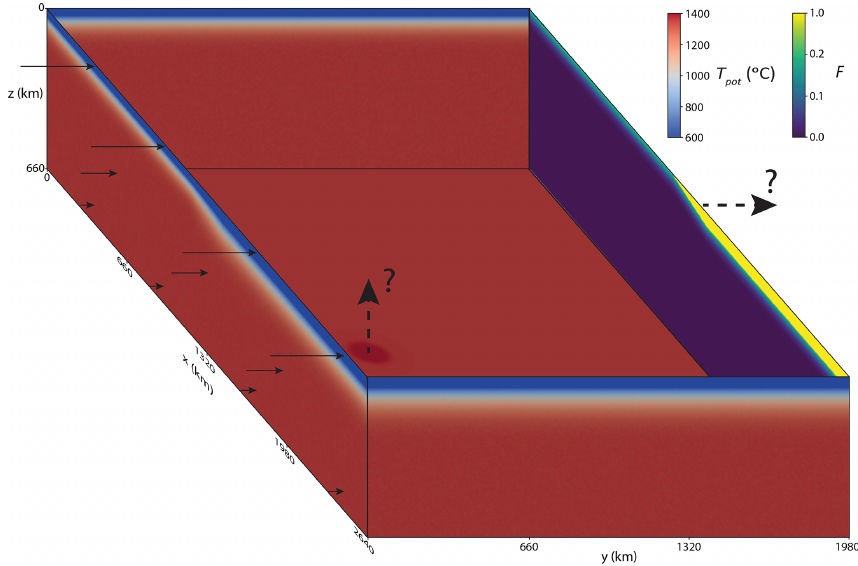
Figure 2. Two-dimensional sections depicting the initial thermal (potential temperature) and compositional (depletion for the “depleted component”) profiles for the models in this work. Depletion ( F ) is defined as the amount of melt extracted from the mantle. Plate motion is imposed at the top boundary from left to right. The left side shows the initial thermal and inflow boundary conditions. The right side shows the initial compositional and inflow boundary conditions. The front and back sides show the thermal side boundary conditions. Solid and discontinuous arrows represent constrained (imposed) and unconstrained (open boundary) velocity boundaries, respectively. For further details on the calculations of the initial profiles, see